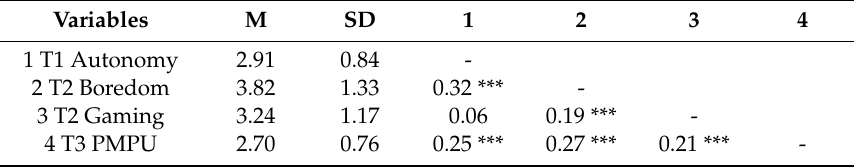
Table 1. Means, standard deviations, and correlations among the main